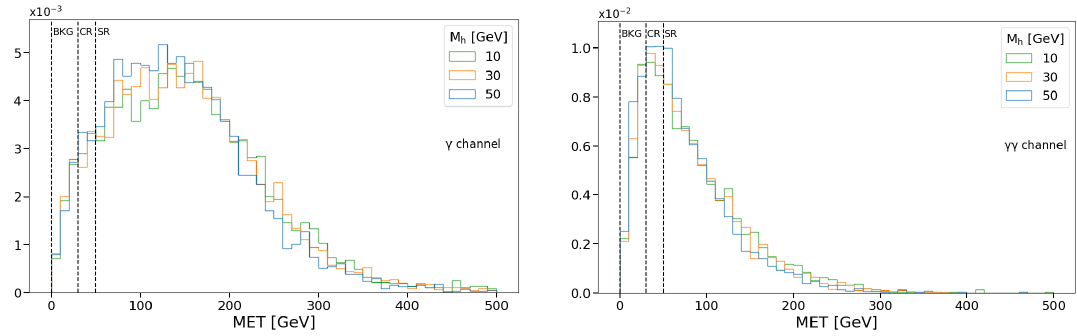
Figure 8 . Missing energy distribution of heavy neutrino decays in 13 TeV analysis, for several M h . Single (multi-) photon set is shown on the left